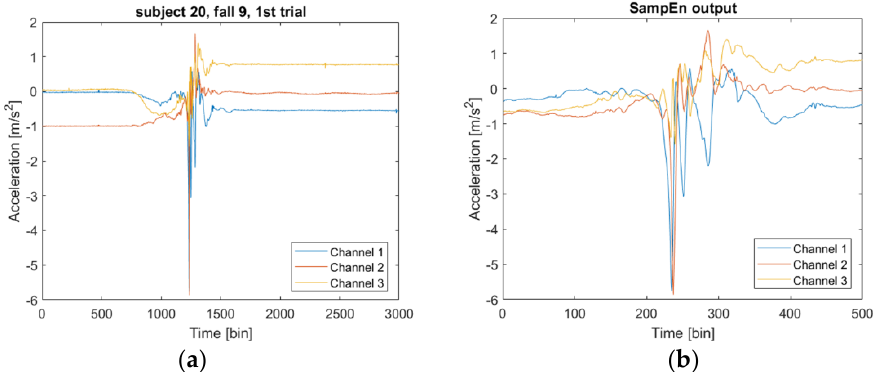
Figure 2. Extraction of a fall event from the SisFall dataset. ( a ) Example of a single dataset containing a fall event (subject 20, fall activity type 9, trial no. 1). The fall event is recognizable between time stamps 1000 and 1500 but there was data unrelated to falls before and after the event of interest. ( b ) With the help of the sample entropy approach, the dataset was cut and reduced to the fall events which was used in further analysis steps. FARSEEING dataset. One accelerometer was attached to the lower back and the other on the thigh of each participant. Only data from the accelerometer on the lower back was analyzed in the present study. Sensors were selected to achieve the highest sim- ilarity with respect to sensor placement.